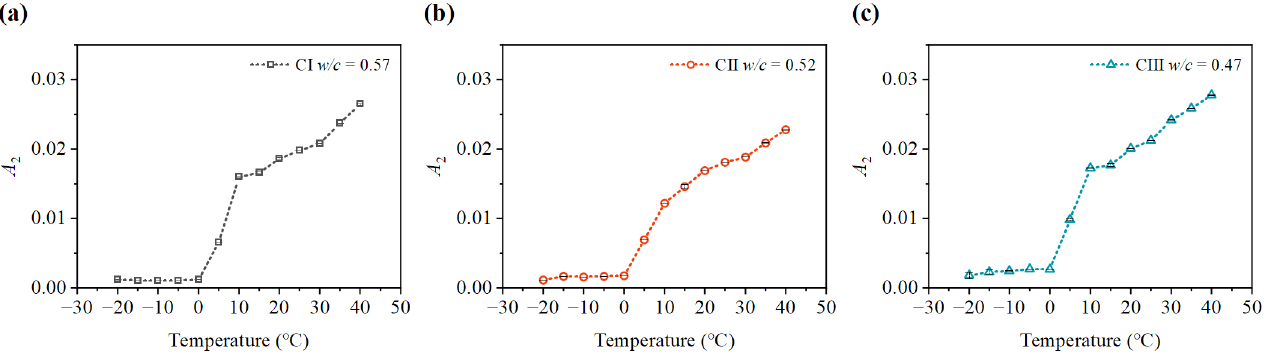
Figure 8. Variation of second harmonic amplitude A 2 at different temperatures. ( a ) second harmonic amplitude A 2 of CI; ( b ) second harmonic amplitude A 2 of CII; ( c ) second harmonic amplitude A 2 of